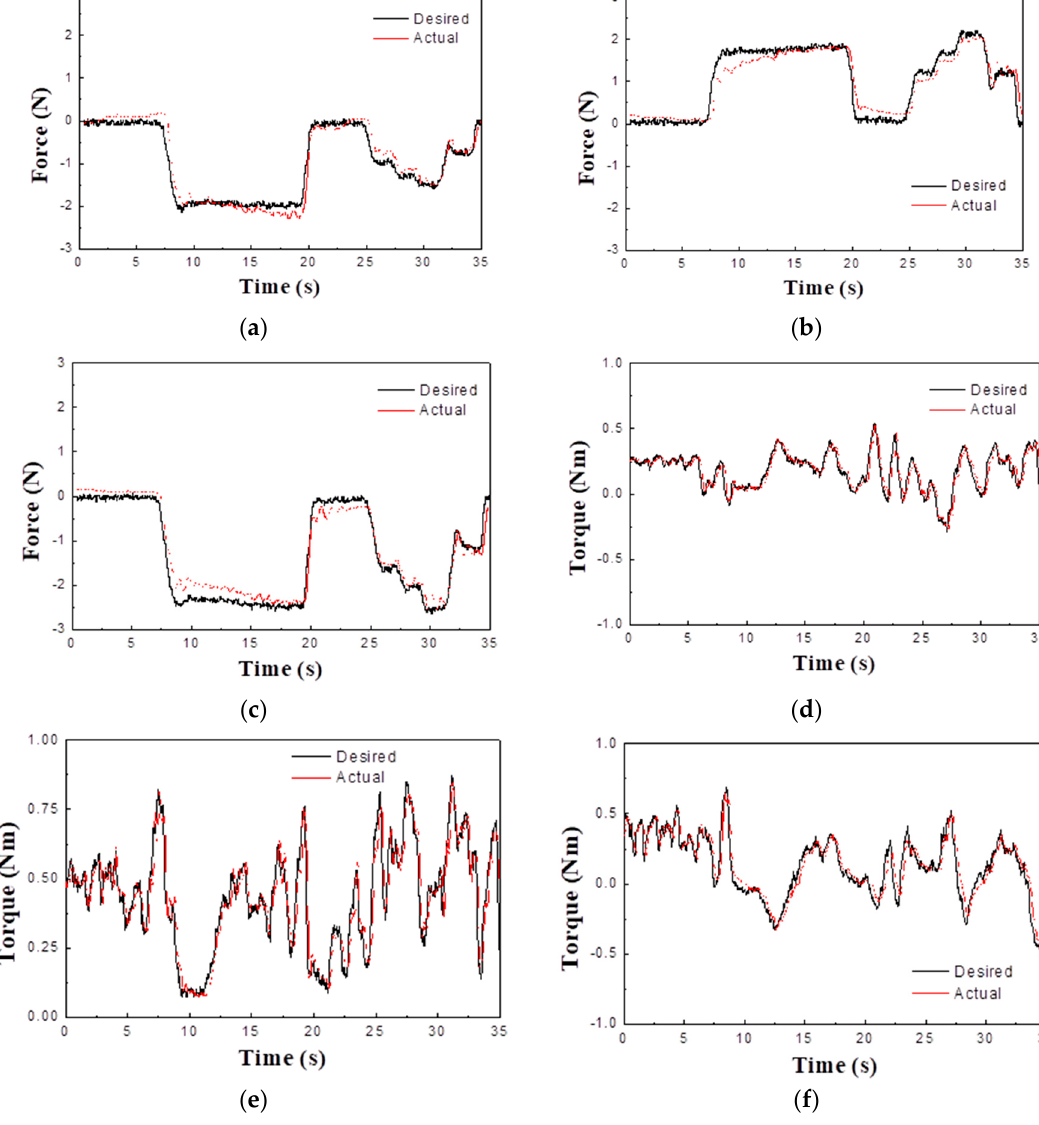
Figure 16. Force/torque tracking control results of the haptic master; ( a ) x -axis force; ( b ) y -axis force, ( c ) z -axis force; ( d ) pitching torque; ( e ) rolling torque; ( f ) spinning torque.